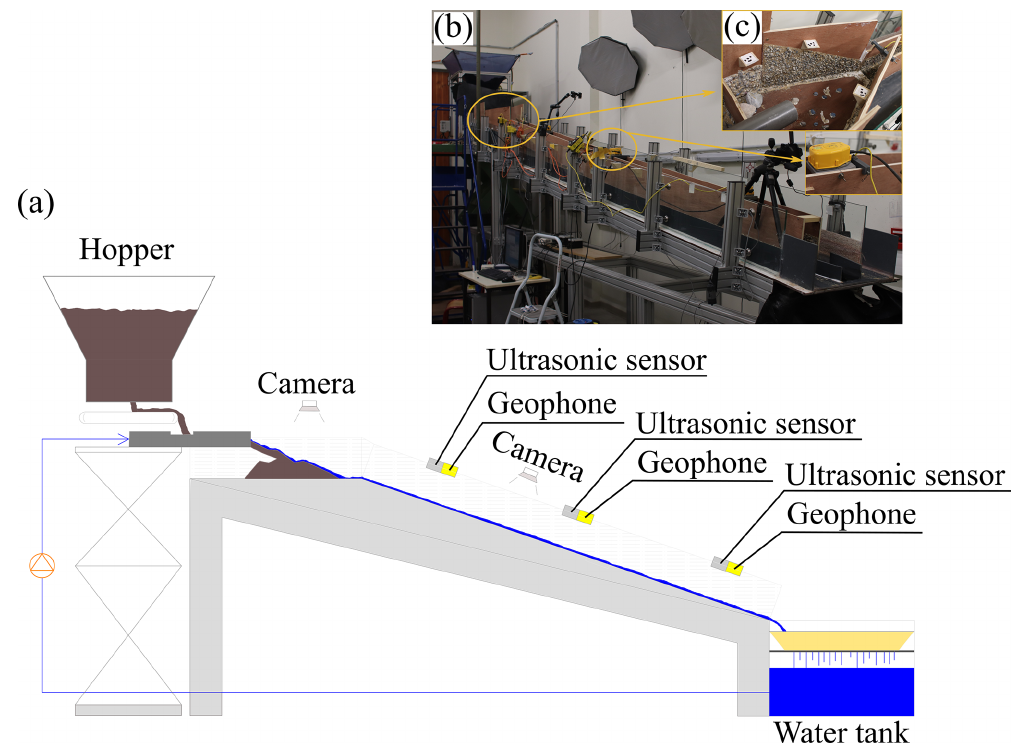
Figure 3. (a) Scheme of the flume with the instrumental equipment. (b) A photo of the flume. (c) A zoom-in of (i) the upstream storage area and (ii) one of the three sections equipped with a geophone (yellow device) and an ultrasonic sensor (grey